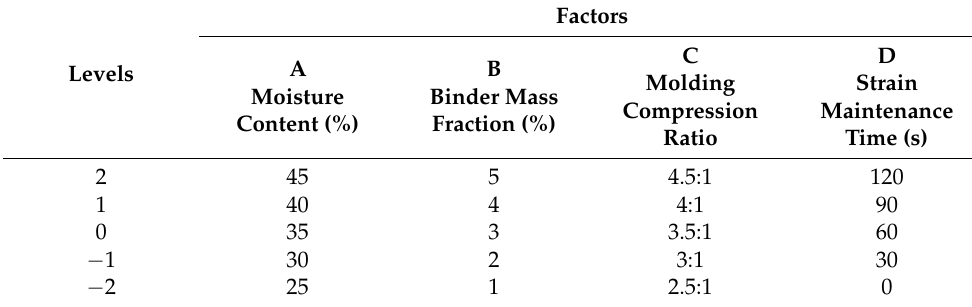
Table 2. Actual and coded levels of cold compression molding test.